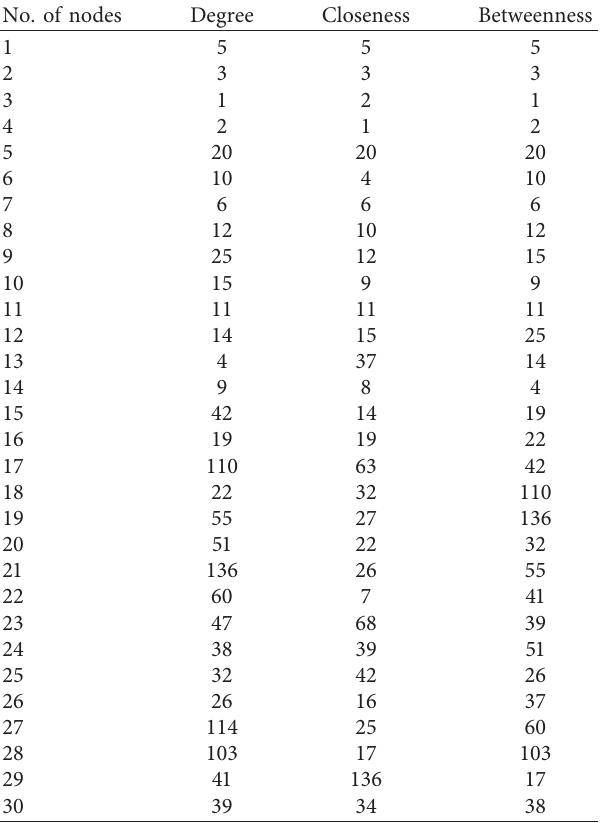
Table 1: The opinion leaders identified based on three indexes of centrality.